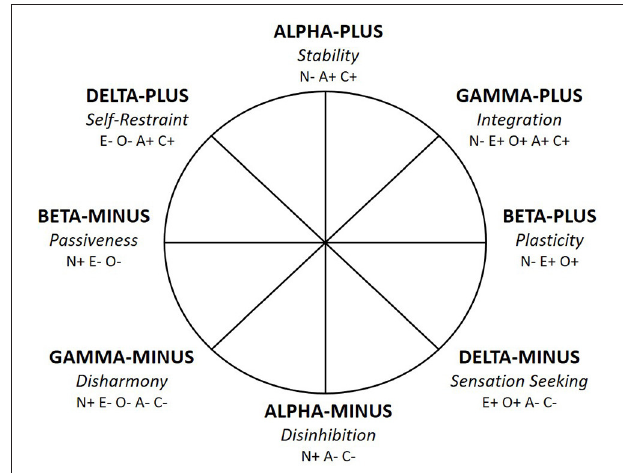
FIGURE 2 | The Circumplex of Personality Metatraits—revised (10). N, Neuroticism; E, Extraversion; O, Openness to Experience; A, Agreeableness; C, Conscientiousness; + denotes the positive pole of a trait; – denotes the negative pole of a trait.